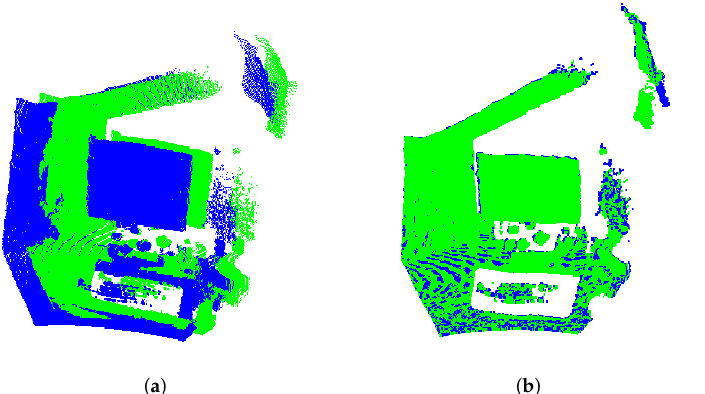
Figure 13. Alignment of indoor scenes of Lab. 1 model: in ( a ) 3D-NDT and ( b ) UPS